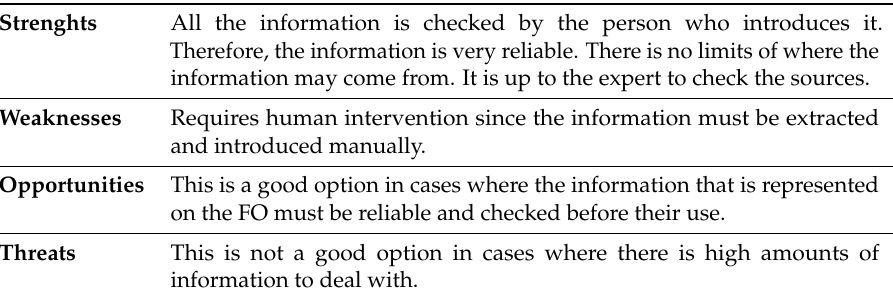
Table 2. SWOT analysis for the manual